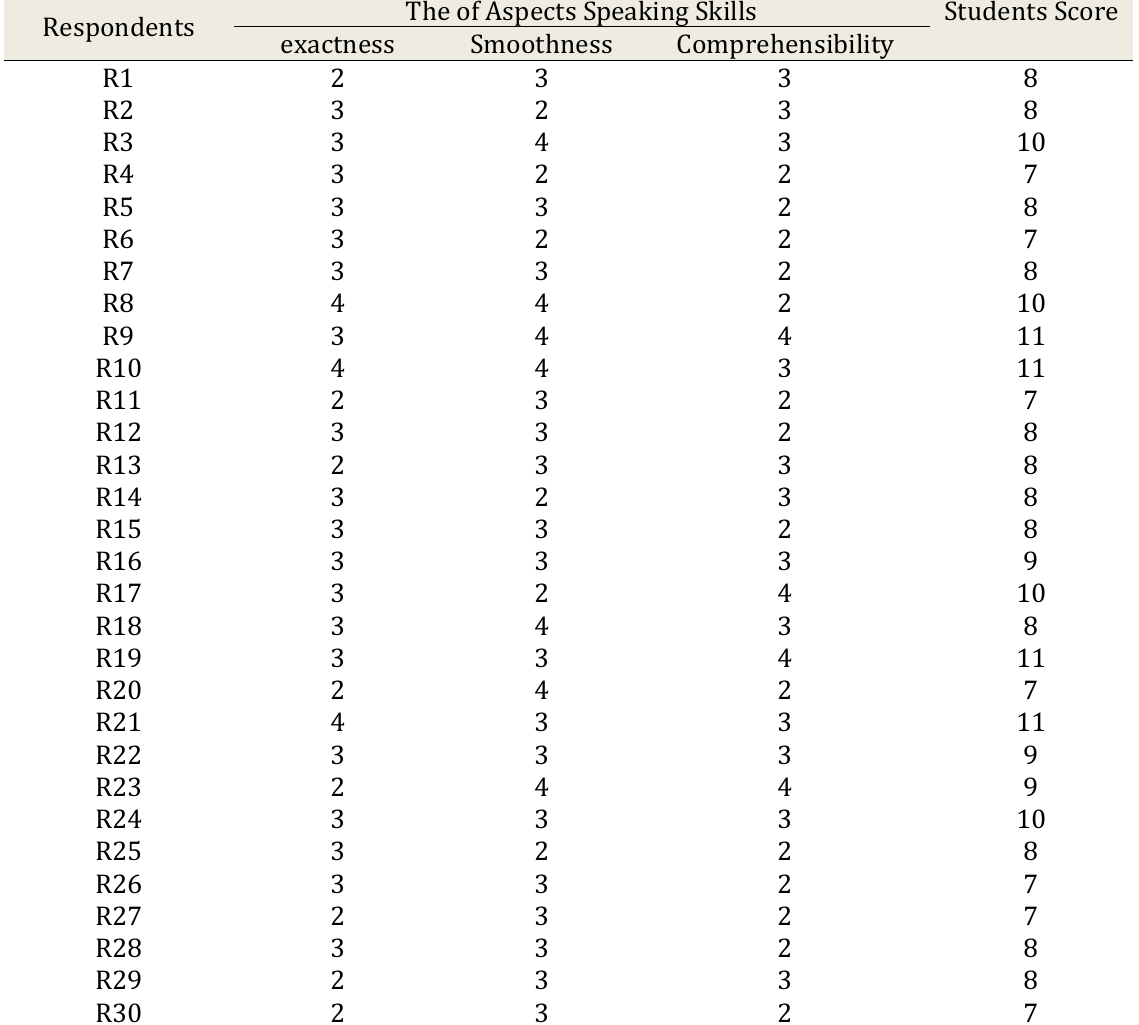
Table 4.21 The Score of Students' Posttest Result in Control Class